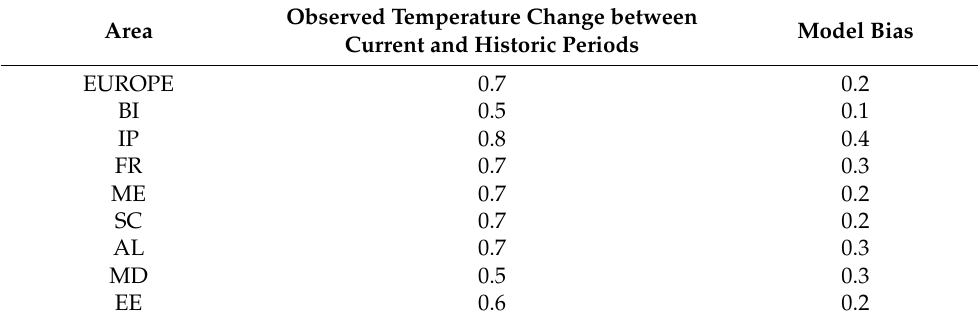
Table 2. Observed temperature change between current (1981–2010) and historic (1951–1980) period and the model bias (E-OBS—Model) for the entire European domain and the subregions examined. Units are in ◦ C. Observed Temperature Change between Area Model Bias Current and Historic Periods EUROPE 0.7